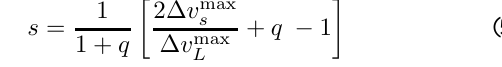
Fig. 5. Contour-plots of constant values of s for velocity shock thresholds, ∆ v max s = v 0 / 2 during clattering. The values of the parameter s are presented in terms of percentage of the bar from its center. The plot shows that only half of the [ q,e e ] design space provides bar configurations to meet the above threshold. For a given e e , the extent of the safe-zone can be increased by increasing q